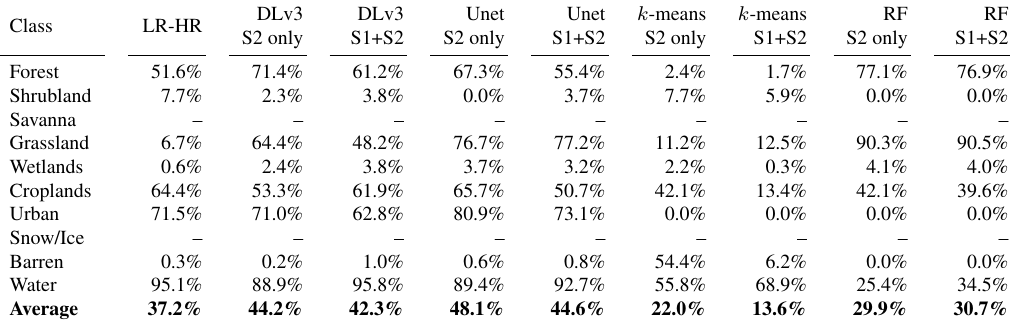
Table 3. Class-wise and average accuracies achieved on the DFC2020 validation dataset for different benchmarks. S2 only indicates that only Sentinel-2 data have been used for the prediction, whereas S1+S2 indicates the case of Sentinel-1/Sentinel-2 data fusion. LR-HR indicates the baseline check of evaluating the MODIS-derived low-resolution labels against the high-resolution DFC2020 reference labels.